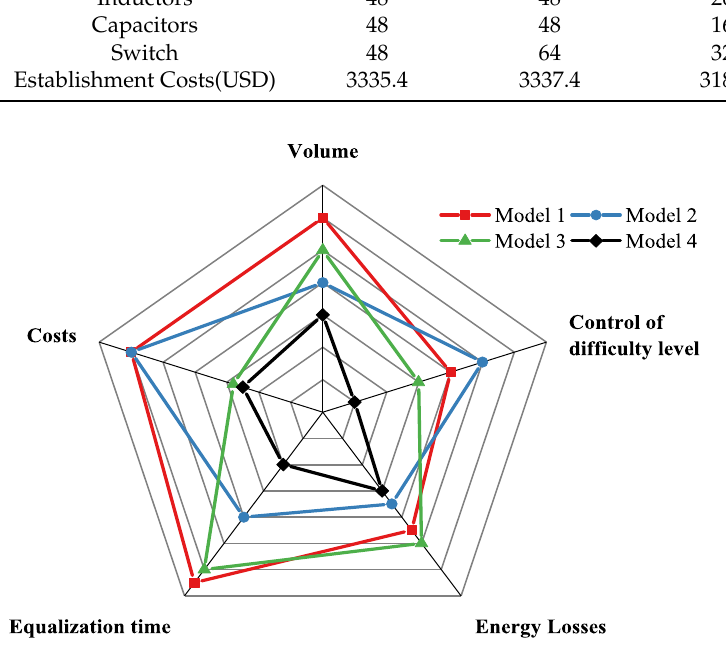
Figure 14. Equilibrium process of the four circuits in the static